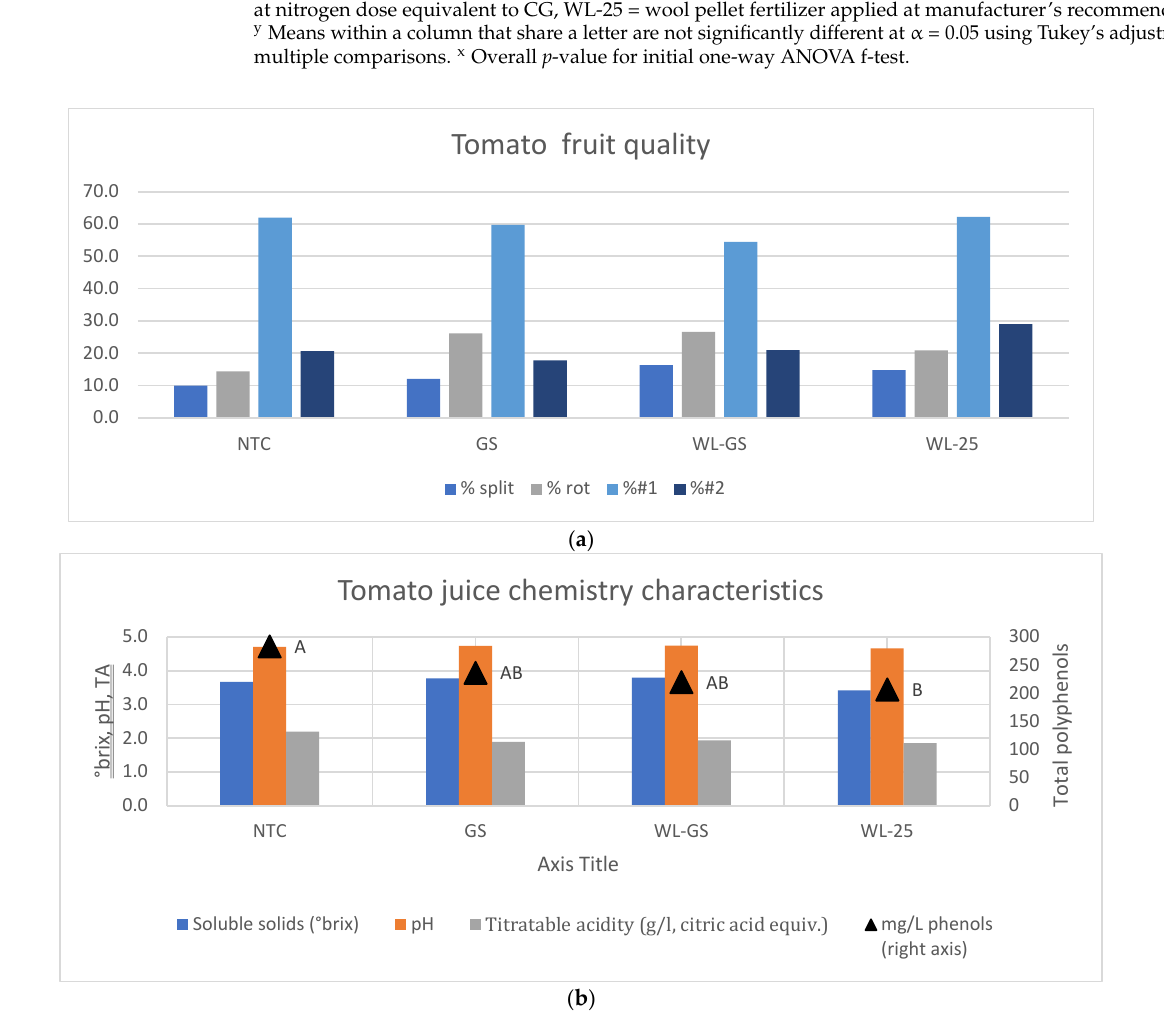
Figure 2. Fruit quality and juice chemistry characteristics for tomatoes grown with four fertility treatments. ( a ) Fruit quality presented as mean percent of all fruit harvested per fertility treatment that showed defects (splitting, rots) or were distributed into grade categories (#1, #2). No differences observed among treatments. ( b ) Mean values for juice chemistry characteristics from fruit grown under four fertility treatments. Values presented for each characteristic which share a common letter do not differ at α = 0.05 when adjusted using Tukey’s comparison for multiple treatments. NTC = non-treated control, GS = growers’ standard fertilizer program, WL-GS = wool pellet fertilizer applied at nitrogen dose equivalent to CG, WL-25 = wool pellet fertilizer applied at manufacturer’s recommended